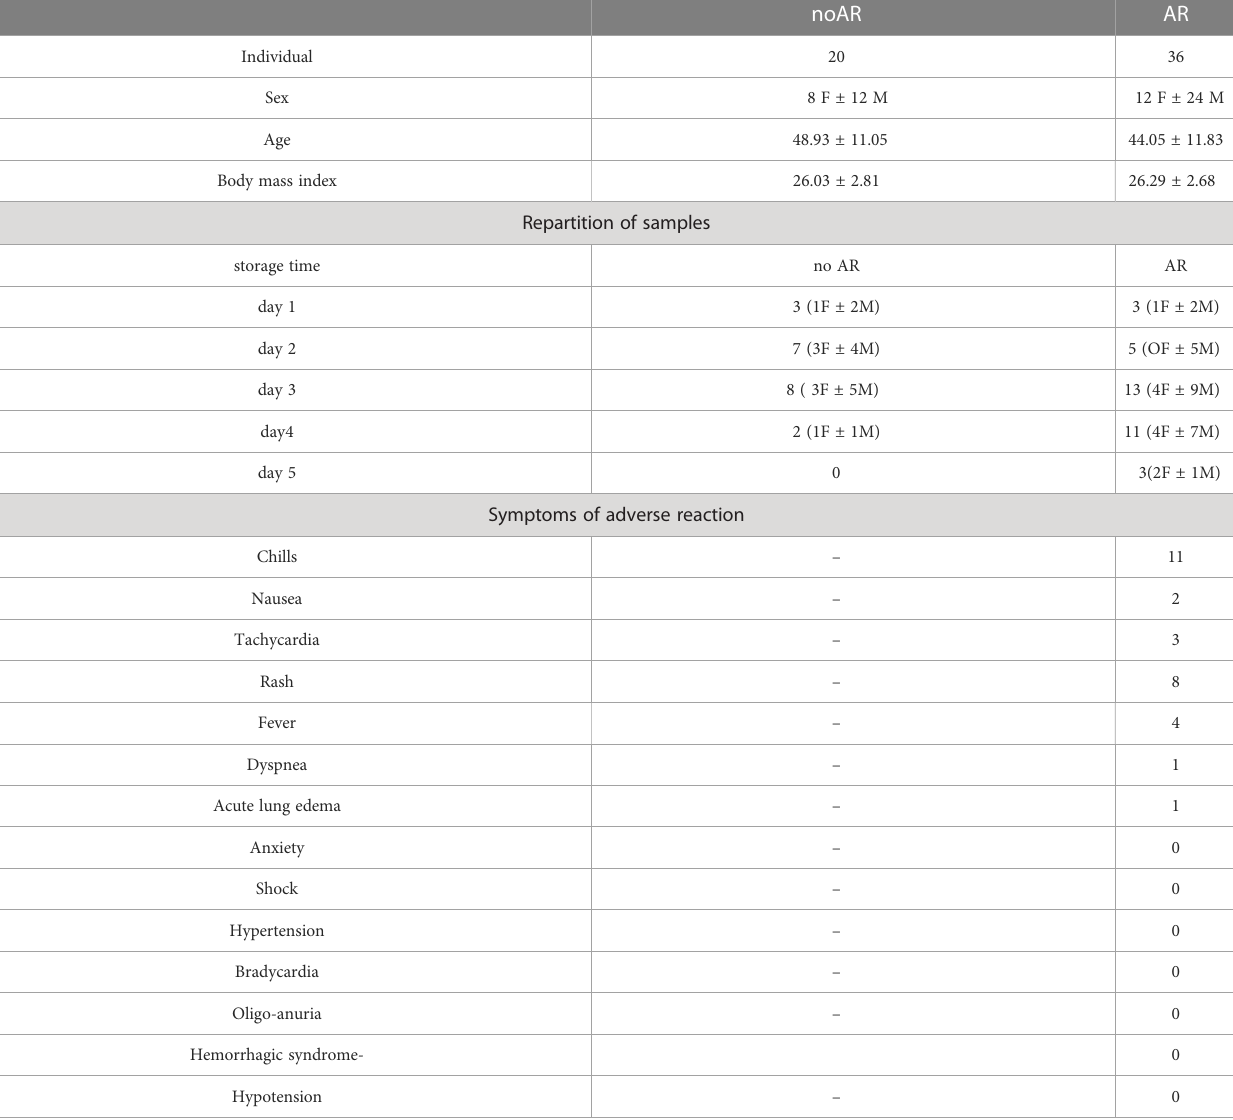
TABLE 1 Donor pro fi le, sample and outcome in transfused